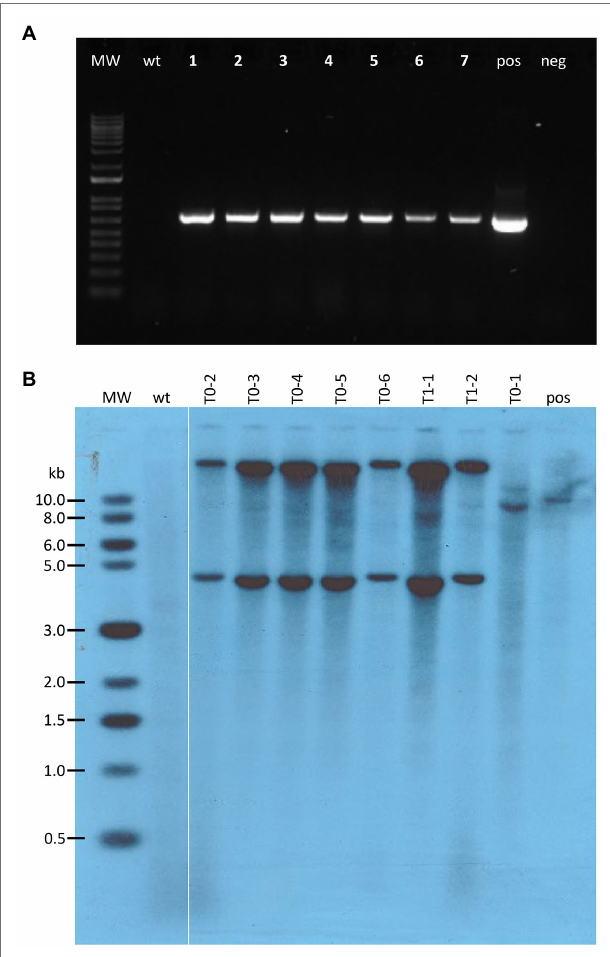
FIGURE 5 | Regeneration and growing of T0 plants. (A) Regenerating plants on a rooting medium containing selective agent 0.2 mg/L of ethametsulfuron; (B) teosinte regenerated from embryogenic callus displays an independent shoot and root system; (C) regenerated T0 plants in a growth chamber; (D) “tassel-ear” on regenerated teosinte plant that has both male (stamens) and female (gynoecia) at the top of the plant. TABLE 3 | Transgene copy number analysis. *